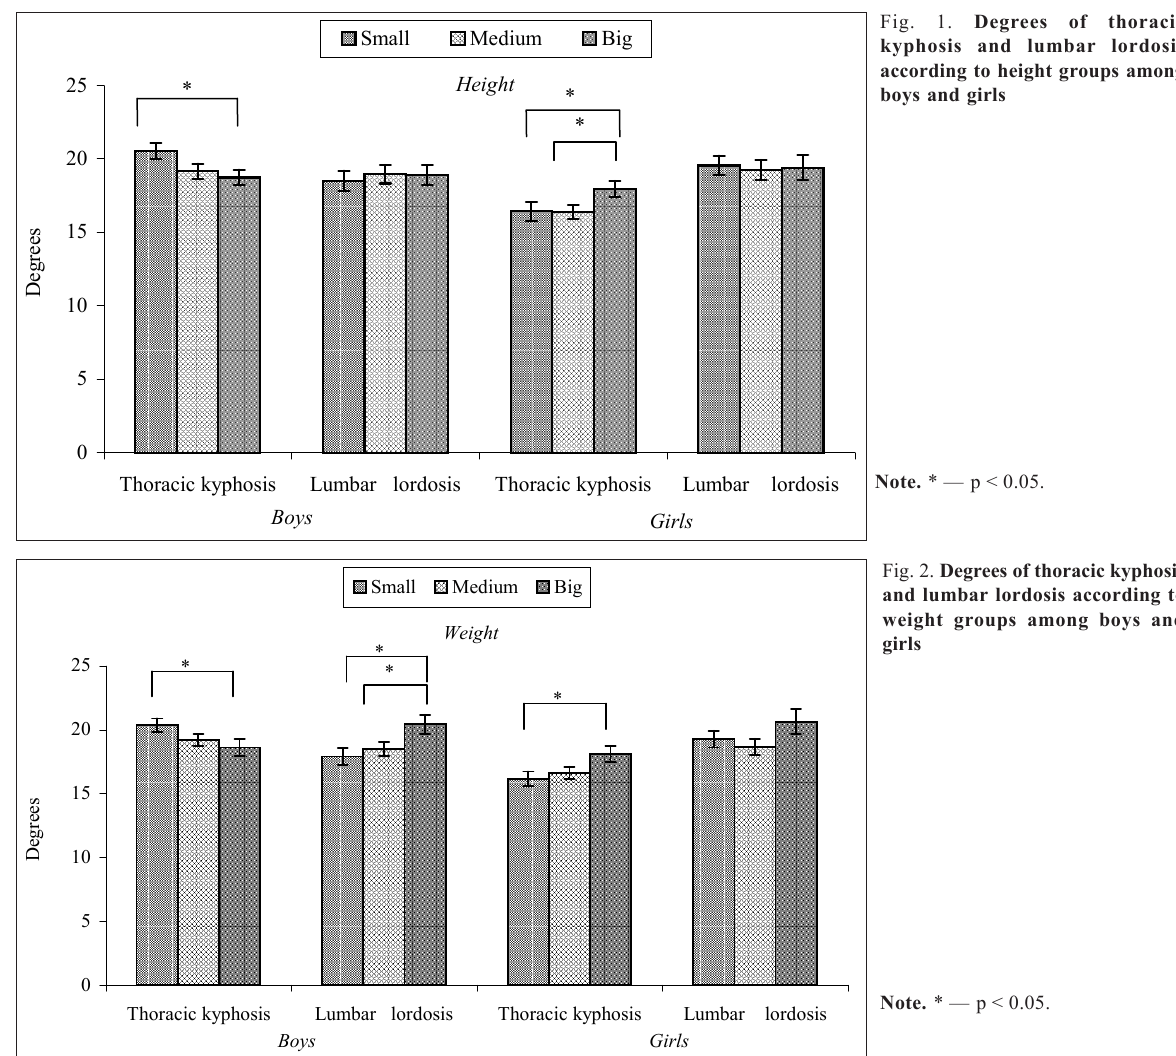
Fig. 1. Degrees of thoracic kyphosis and lumbar lordosis according to height groups among boys and